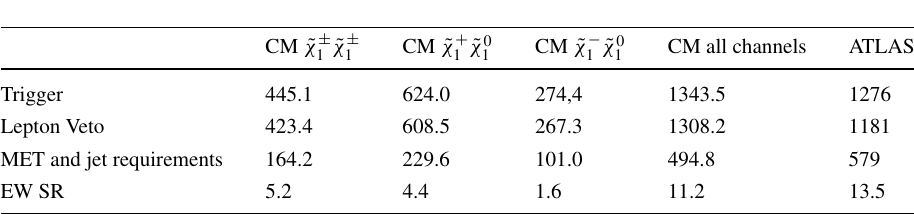
selection criteria for signal events for direct electroweakino production and the strong channel channel where the chargino is produced in gluino decays